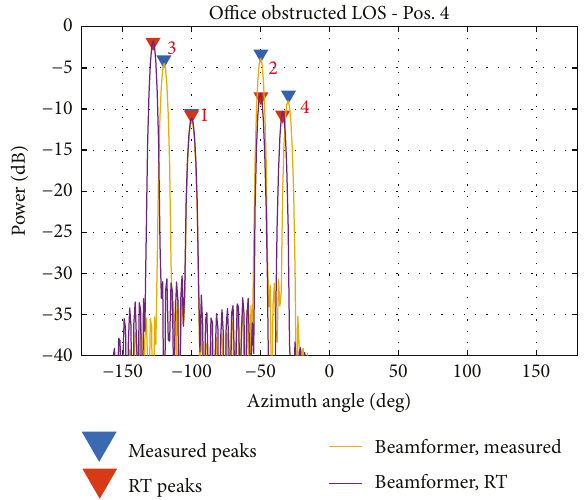
Figure 25: The identi fi ed 4 dominant paths in the measured and RT-simulated channels and the associated multiple beams for Tx position 4 with the metallic plate in the o ffi ce scenario.